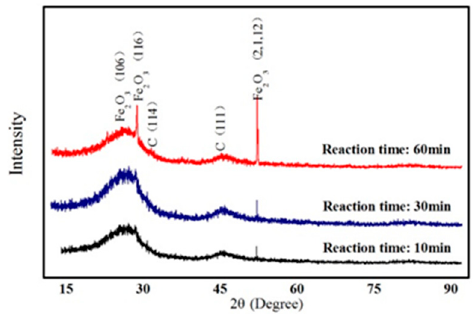
Figure 6. XRD pattern of BC-nZVI after reaction.